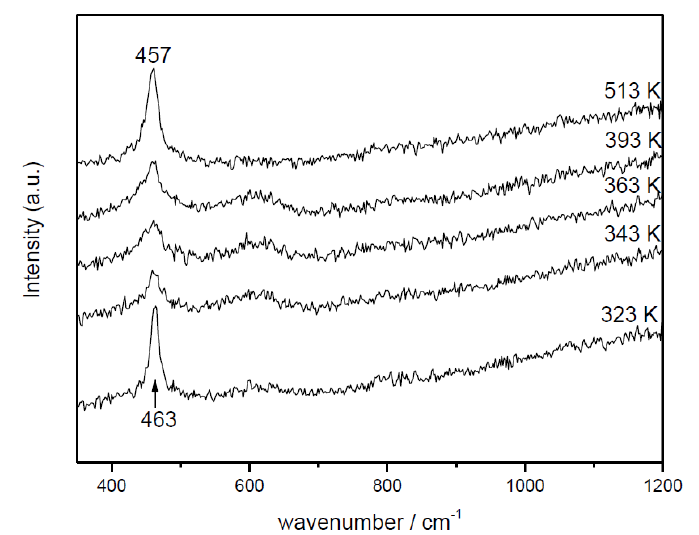
Figure 8. Raman spectra obtained for Ce at the indicated temperatures. Note: This figure is adapted with permission from